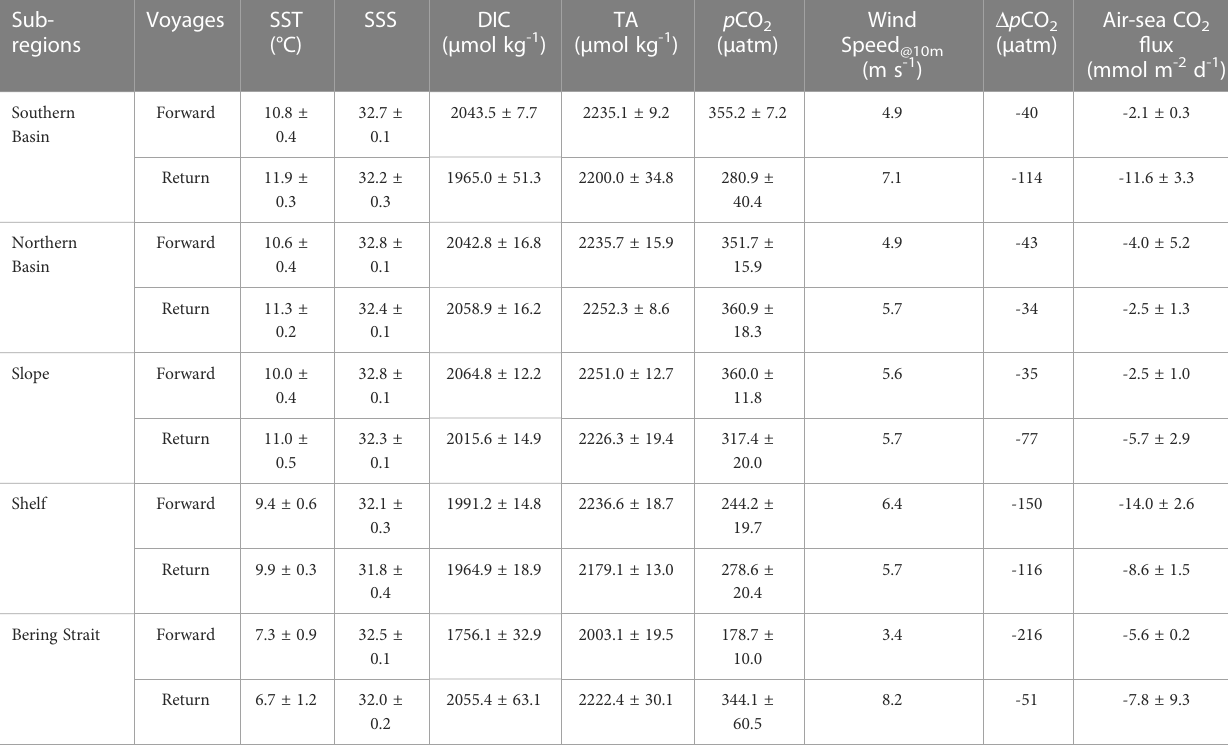
TABLE 1 Summary of average water properties and the air-sea CO 2 fl uxes in different sub-regions. Sub- Voyages regions